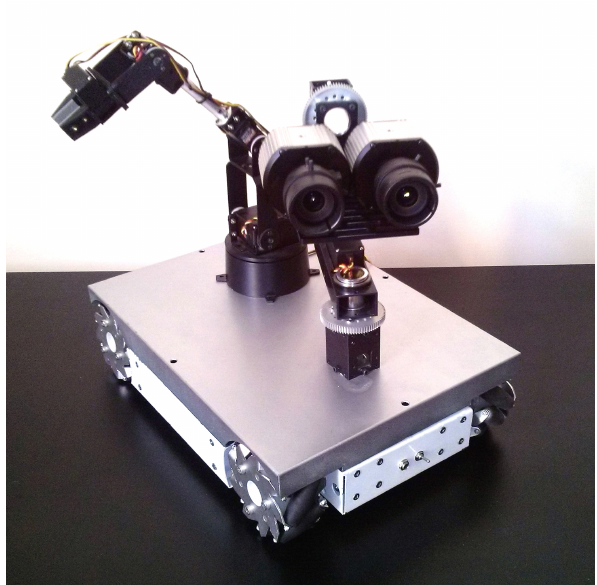
Figure 8: The mobile robotic platform equipped with 3D machine vision stereoscopic